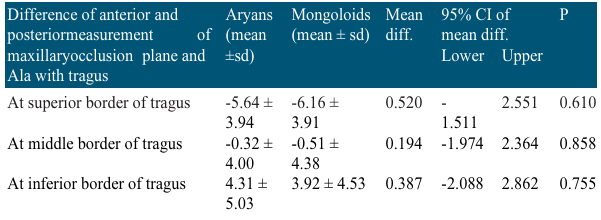
Table 2: Comparison of difference in anterior and posterior measurement of ala-tragus and maxillary occlusal plane between Aryans and